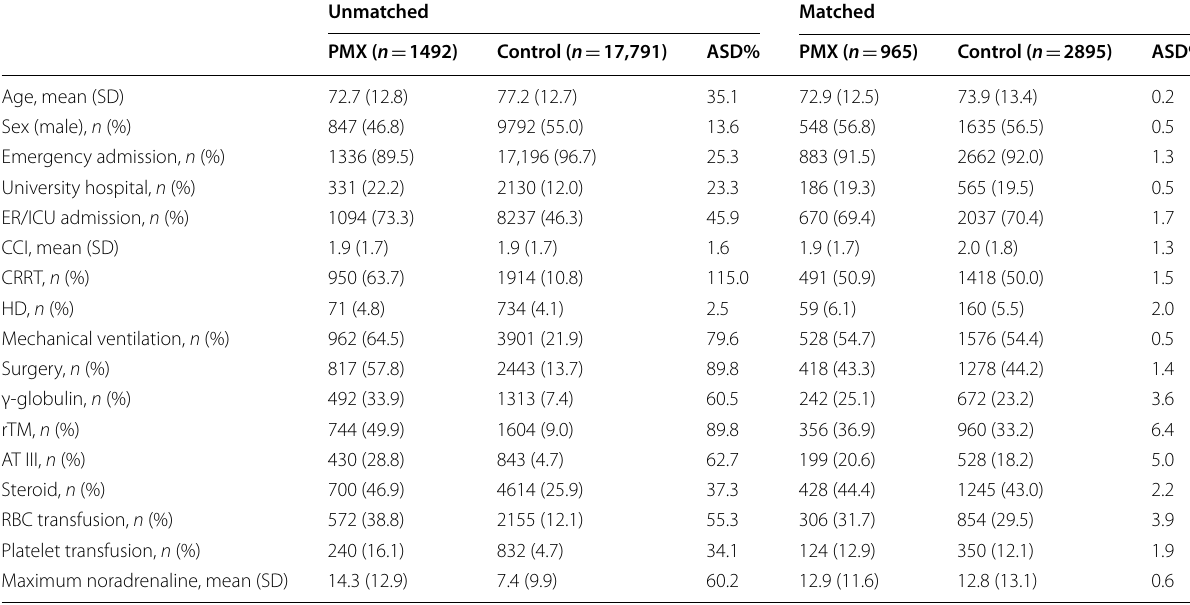
Table 1 Baseline patient characteristics before and after propensity score